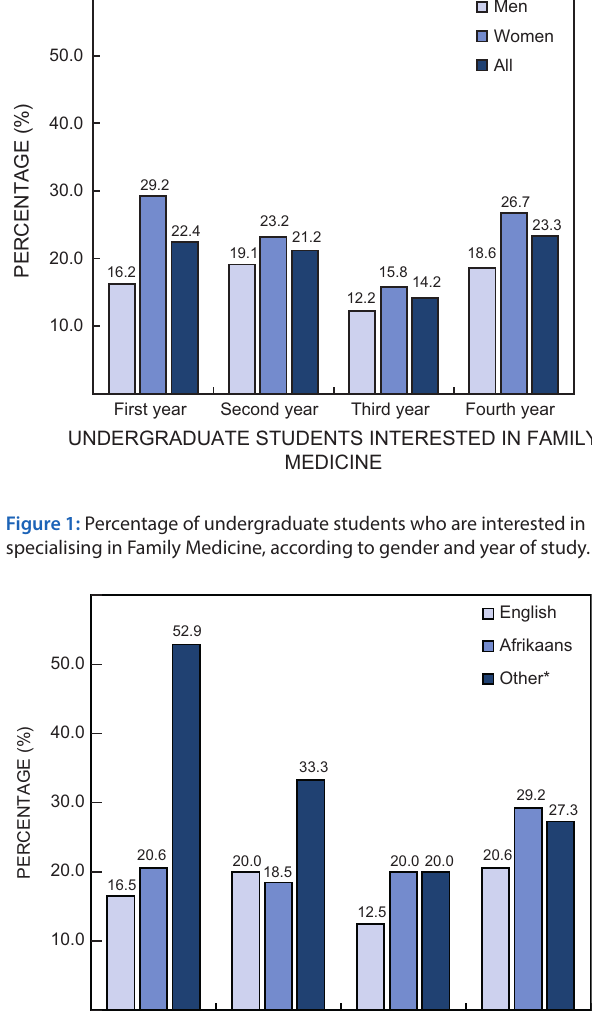
Figure 2: Percentage of undergraduate students who are interested in specialising in Family Medicine, according to home language and year